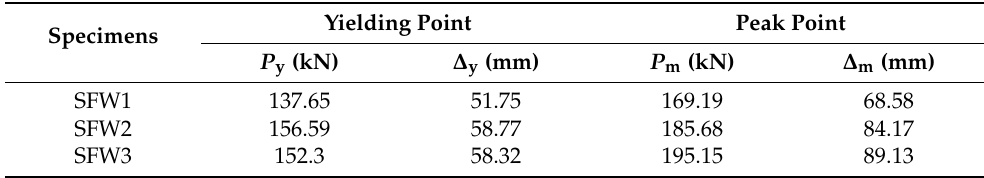
Table 5. Skeleton curves of